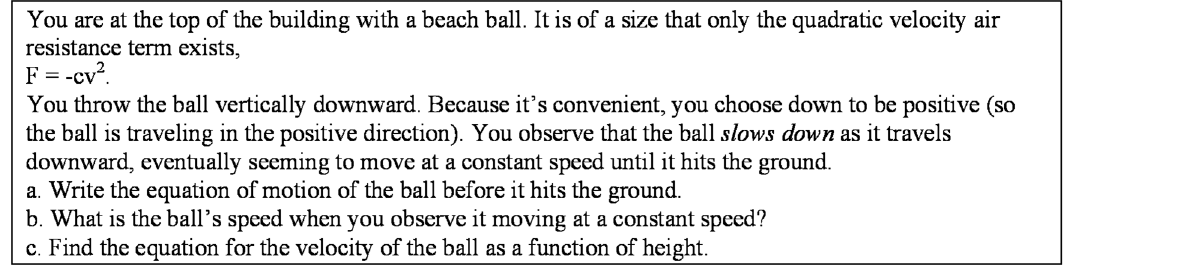
FIG. 4. Problem statement from the midterm activity in all years as well as the final examination of years 1 and 3. Only the part of the question concerning vertical motion is